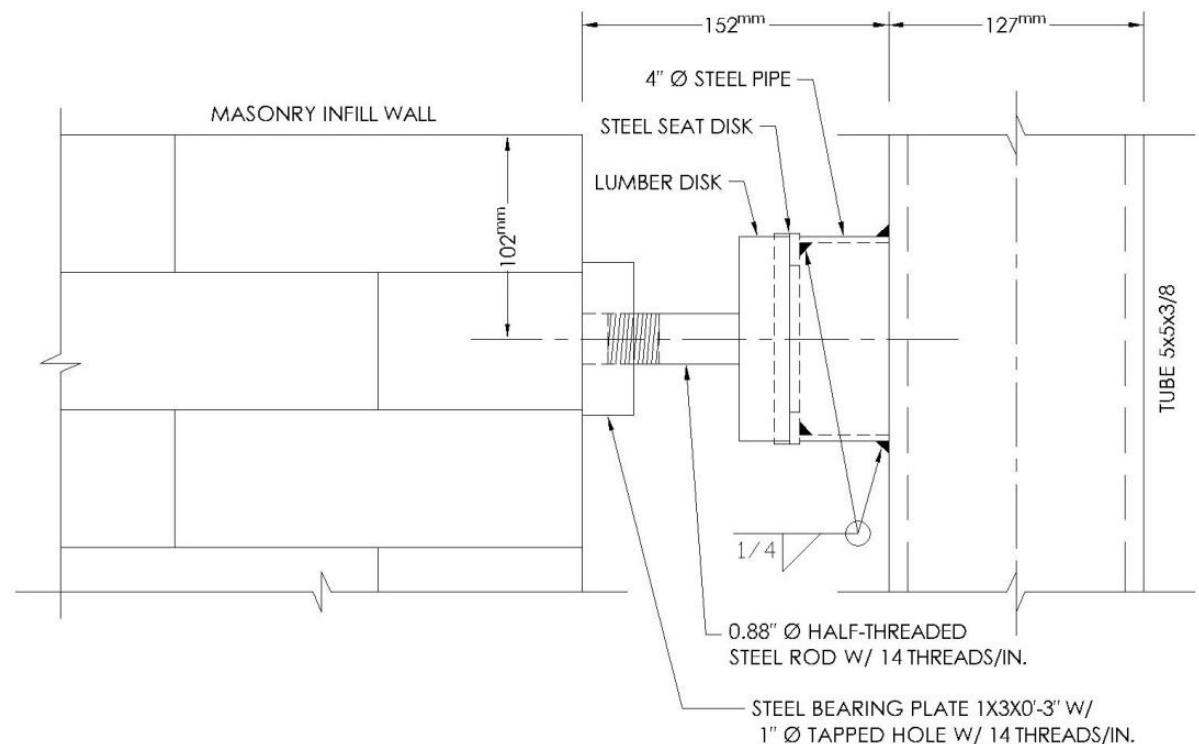
Figure 5. Fuse mechanism